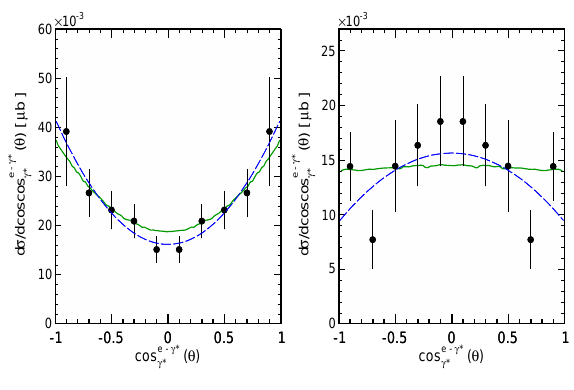
Figure 8. Angular distributions (black dots) of the leptons in the rest frame of the virtual photon for the dielectron mass of 0 . 14 < M e + e − < 0 . 28 GeV / c 2 (left panel), and with respect to the direction of the charged pion exchange for dielectrons with > 0 . 28 GeV / c 2 (right panel) corrected for the detector ac- M e + e − ceptance. The solid green curves display predictions from the simulations where the dominant source is the Δ (1232) in the low mass bin and the ρ in the high-mass bin (assumed to be isotropic). The dashed blue curve shows a fit with a function A (1 + Bcos 2 ( θ e ))